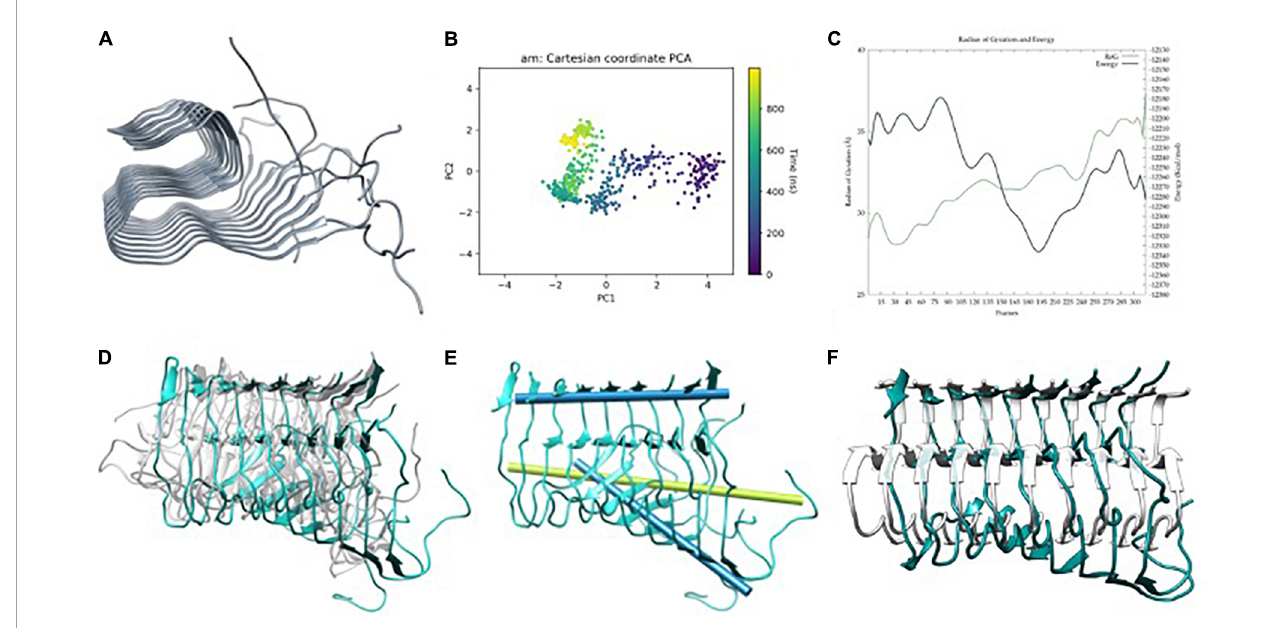
FIGURE2 (A) A β 42 model built from A β 11 − 42 (2MXU) (Xiao et al., 2015) after adding the 1–11 residues, (B) principle component analysis (PCA) of Gaussian accelerated molecular dynamics (GaMD) simulation, (C) energy profile and radius of gyration (RoG) along the GaMD simulation, (D) overlap of representative structures of most populated clusters obtained from GaMD simulations, (E) in blue, metal-free fibril axis representation of 39–41 (top) and 11–15 β -sheets (bottom), in green; 11–15 β -sheets axis of NMR-structure, and (F) overlap between the solid-state NMR (ss-NMR) structure and the lowest energy structure of the GaMD